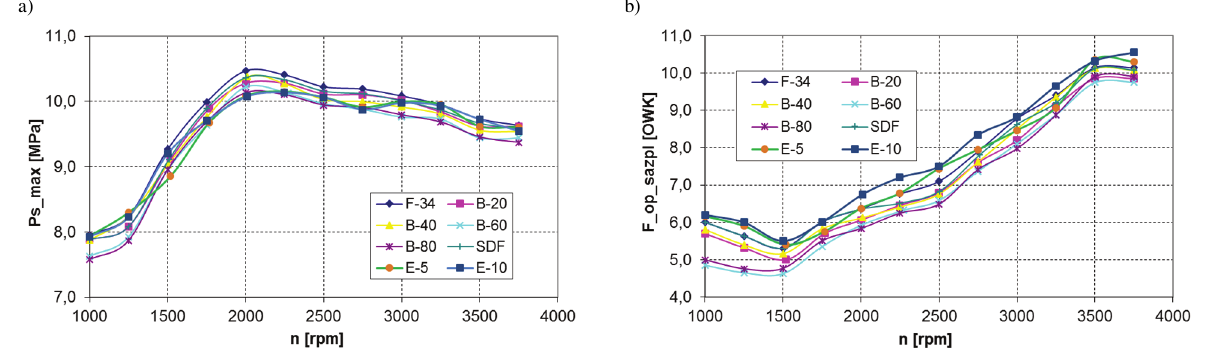
Fig. 5. External characteristic of the engine: a) maximum combustion pressure, b) angle of auto-ignition